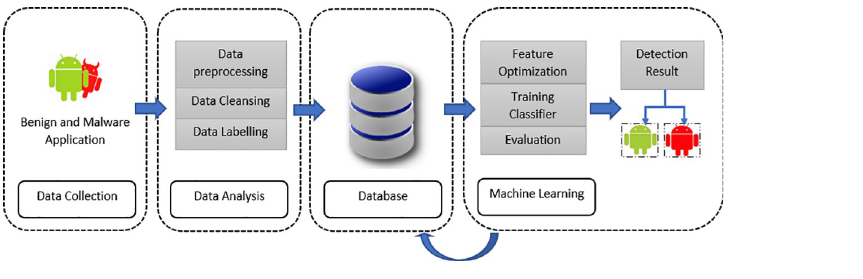
Fig 5. Malware detection